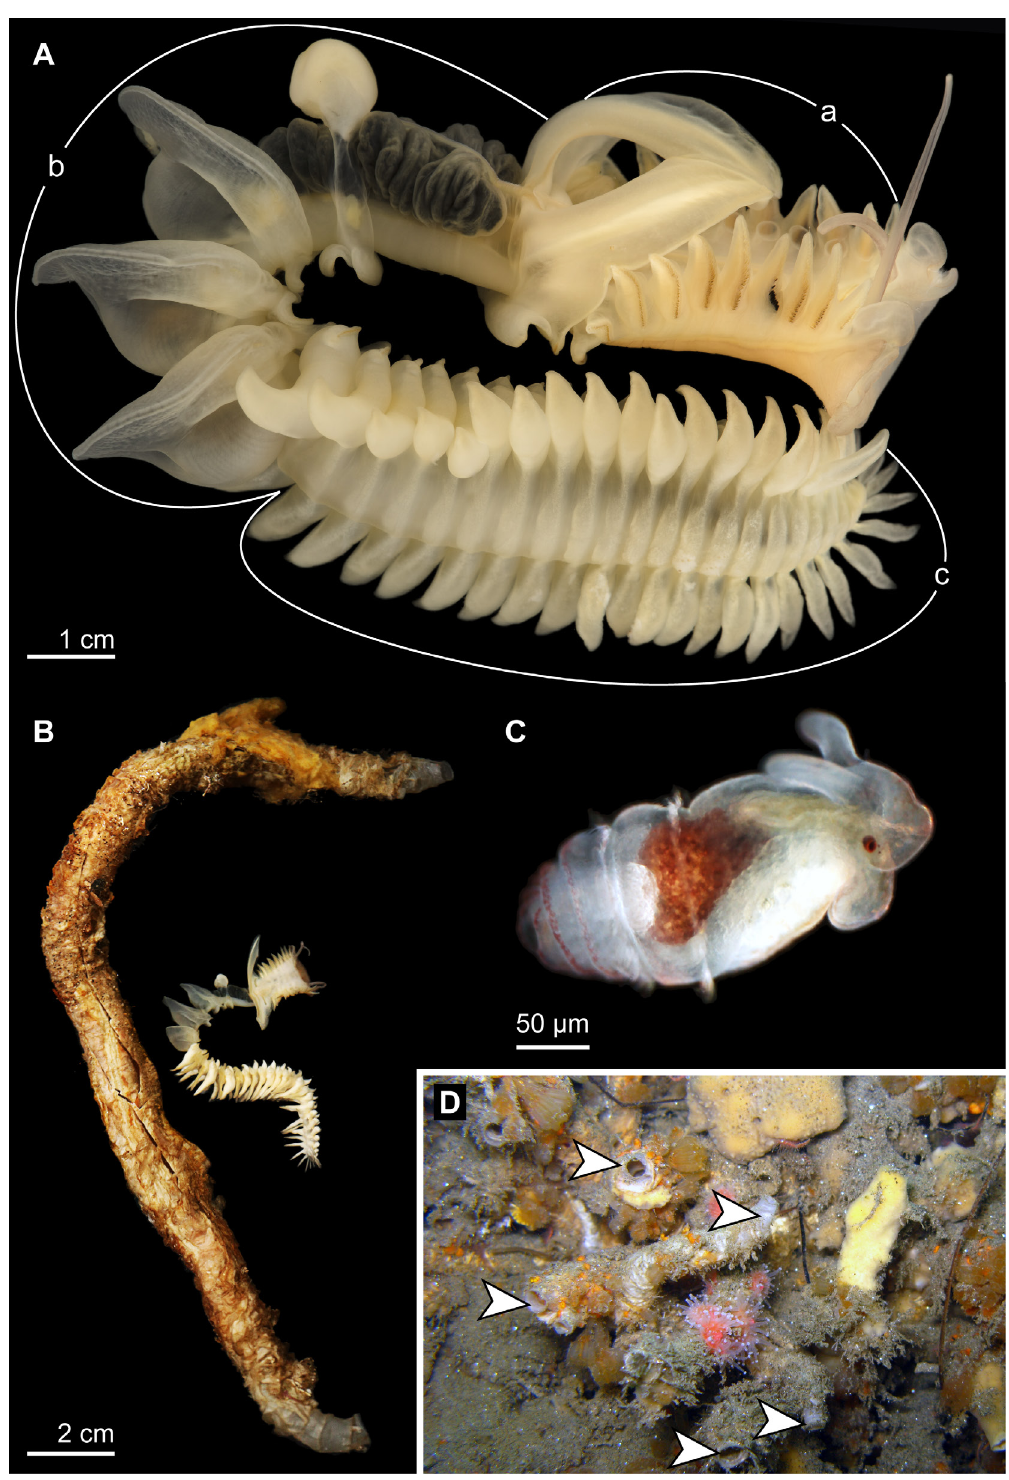
Fig. 1. Chaetopterus dewysee sp. nov. A . Live photograph of a paratype (SIO-BIC A11652), showing the three morphologically distinct regions of a chaetopterid annelid; a = region A, b = region B, c = region C. B . Holotype together with its tube (SIO-BIC A11476). C . Larva of Chaetopterus dewysee sp. nov. collected from a plankton sample off La Jolla and sequenced (GenBank: MN991232). D . Habitat of the new species, tubes are marked with